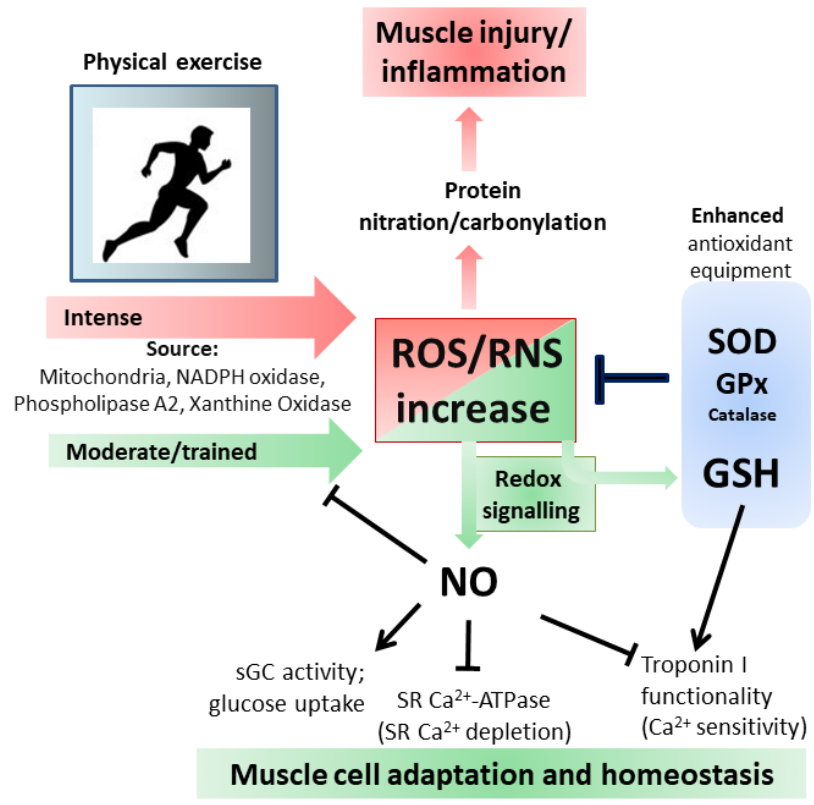
Figure 3. Oxidative and Nitrosative stress / signaling during intense and moderate physical exercise. For details see the text.